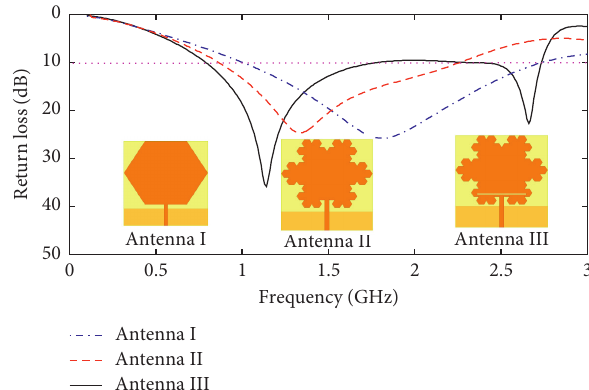
Figure 3: Development stages and the corresponding simulated return losses of the single